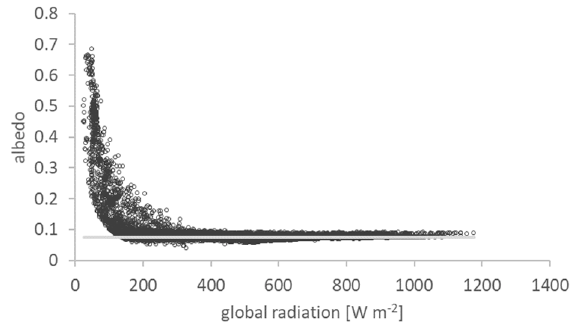
Figure 3. Albedo of fir ( Abies alba ) at Wittnau forest during summer 2017 in relation to global radiation (with equilibrium value shown as gray line).